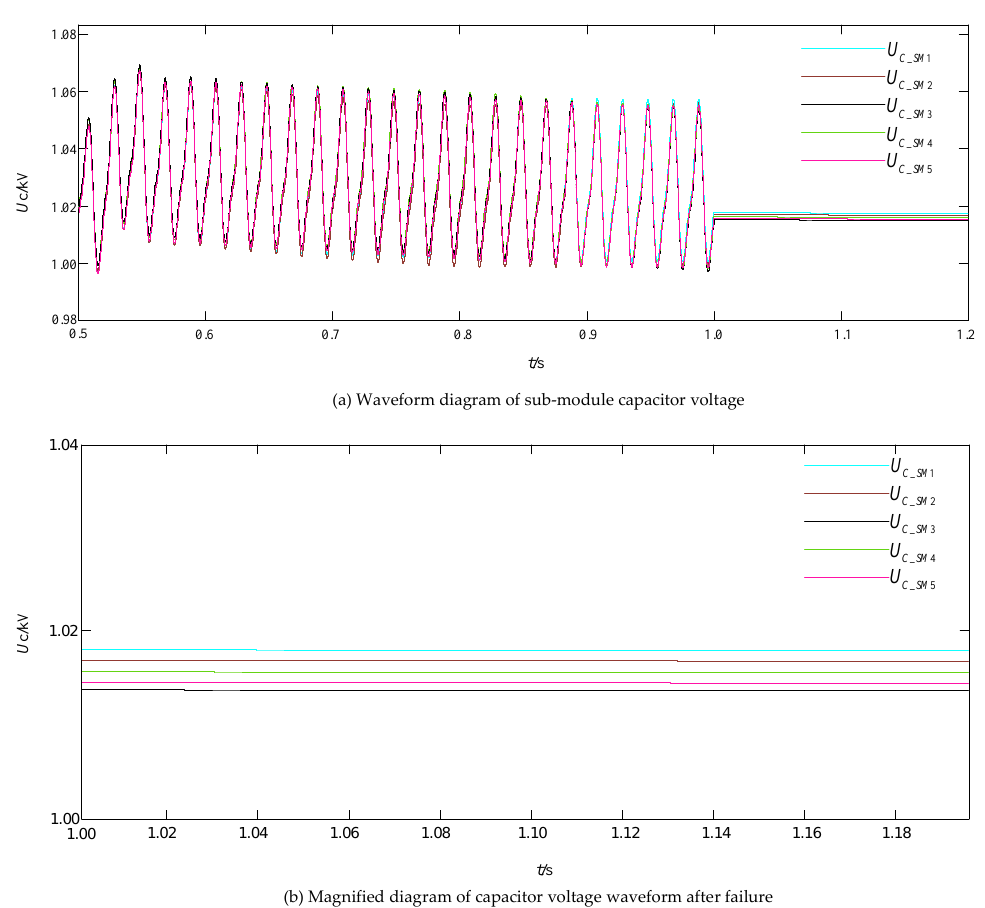
Figure 12. C 1 = C 2 , capacitor voltage of sub-module: ( a ) Waveform diagram of sub-module capacitor voltage; ( b ) Magnified diagram of capacitor voltage waveform after failure. voltage; ( b ) Magnified diagram of capacitor voltage waveform after